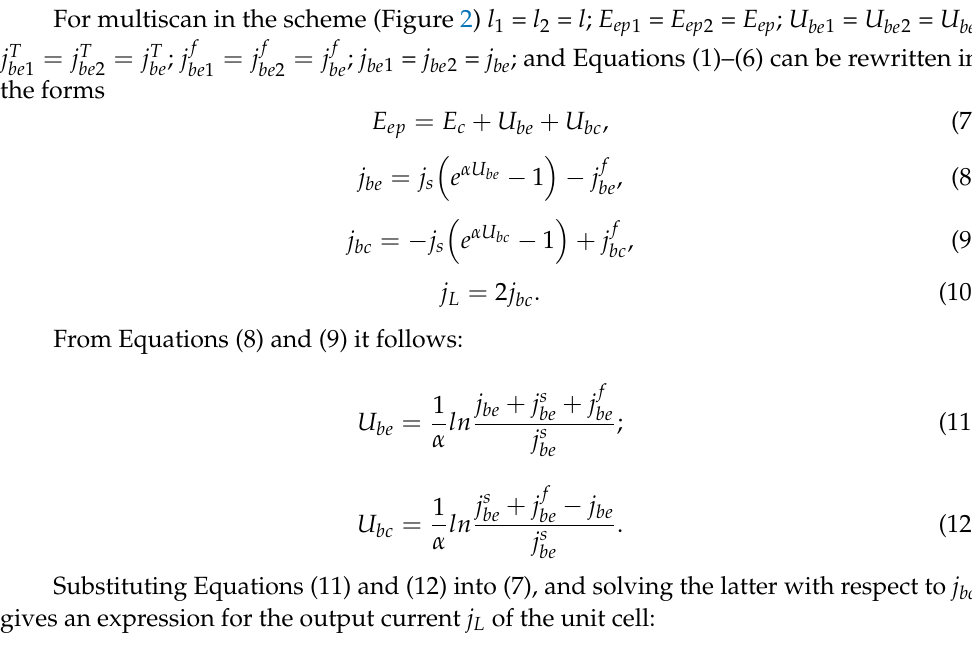
Figure 3. Equivalent multiscan scheme for an elementary cross-section of its structure in the scanistor mode: ( a ) full scheme; ( b ) with the replacement of voltage dividers R 1 and R 2 , and the source of the offset voltage OVS by the voltage sources E ep 1 and E ep 2 at the time of the multiscan survey.